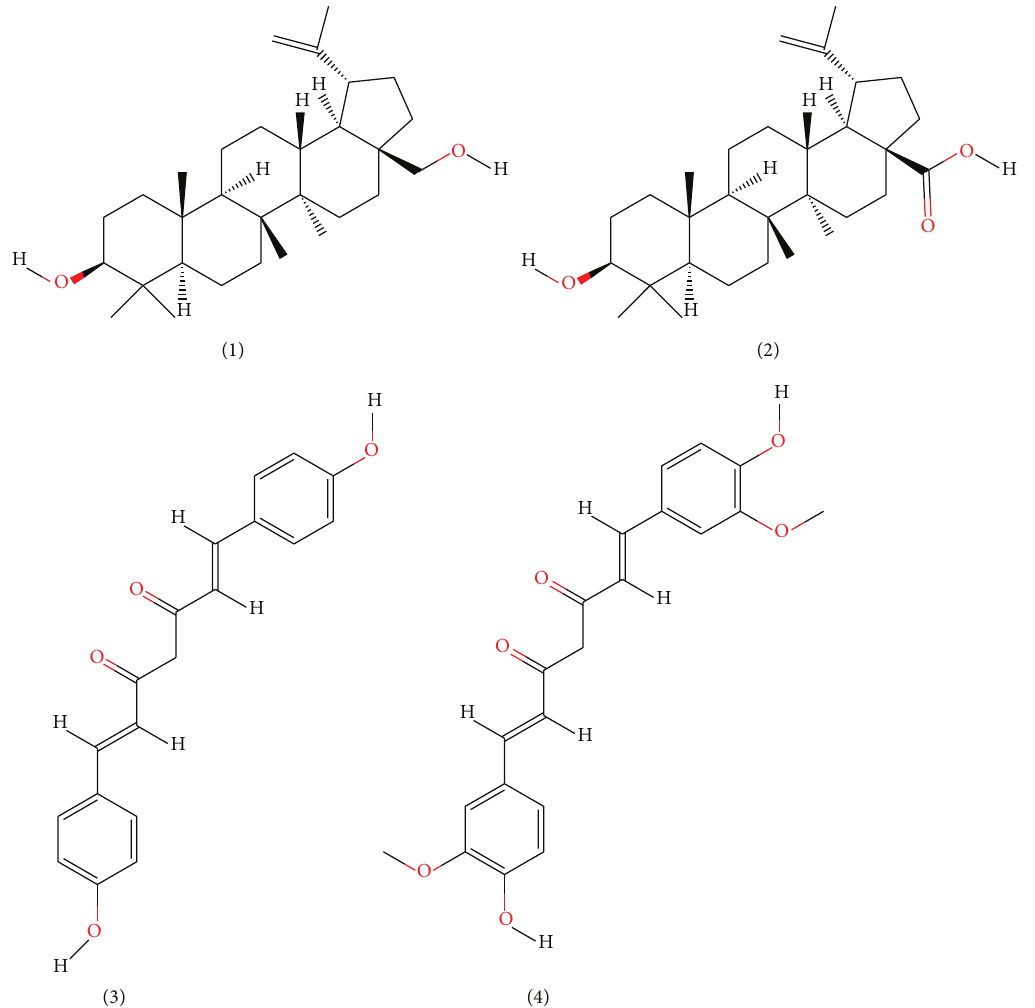
Figure 2: Chemical structure of (1) Betulin, MW 442.72 g/mol; (2) Betulinic acid, MW 456.70 g/mol; (3) Bisdemethoxycurcumin, MW 308.32 g/mol; (4) Curcumin, MW 368.37 g/mol.